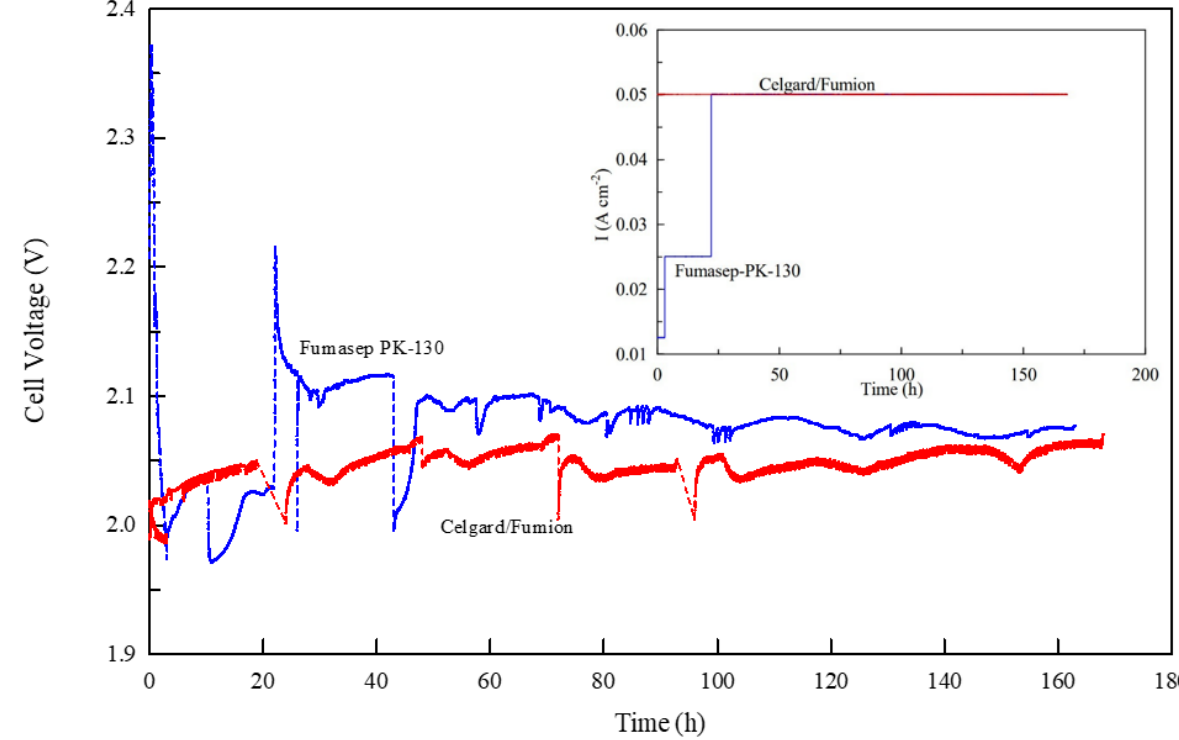
Figure 7. Measurement of cell voltage vs. time for Celgard/Fumion and Fumasep-PK-130 membranes at 25 °C. The inset figure shows the current density profile during the experiment.